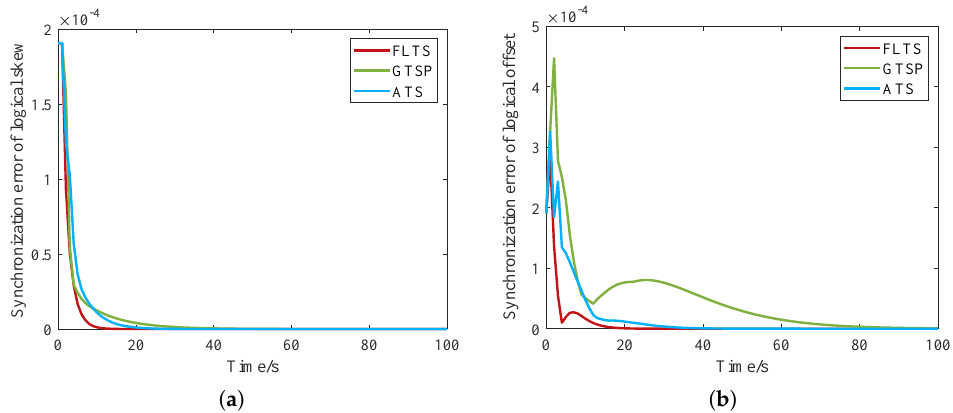
Figure 3. Convergence comparison of the logical clock in whole network. ( a ) Logical clock skew; ( b ) Logical clock offset.